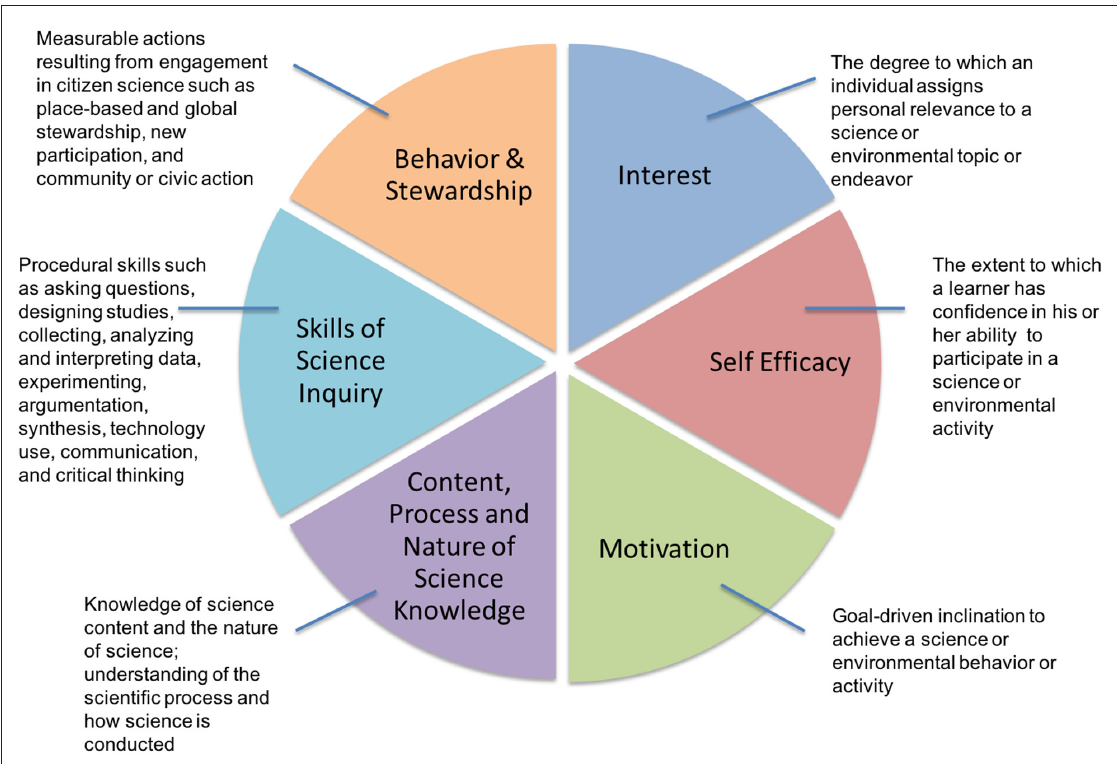
Figure 3: Framework for Articulating and Measuring Individual Learning Outcomes from Participation in Citizen